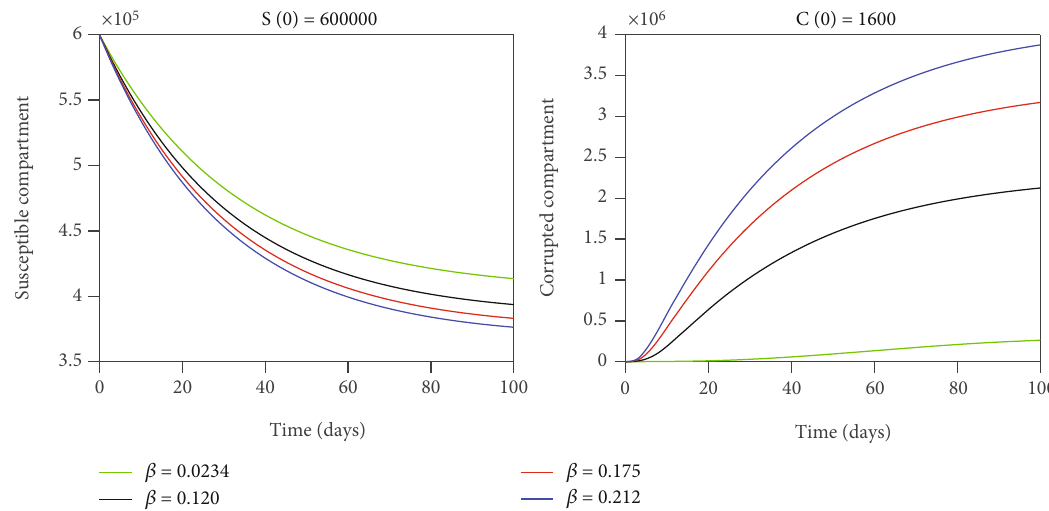
Figure 2: Susceptible and corrupted population with varying e ff ective corruption contact rate, β